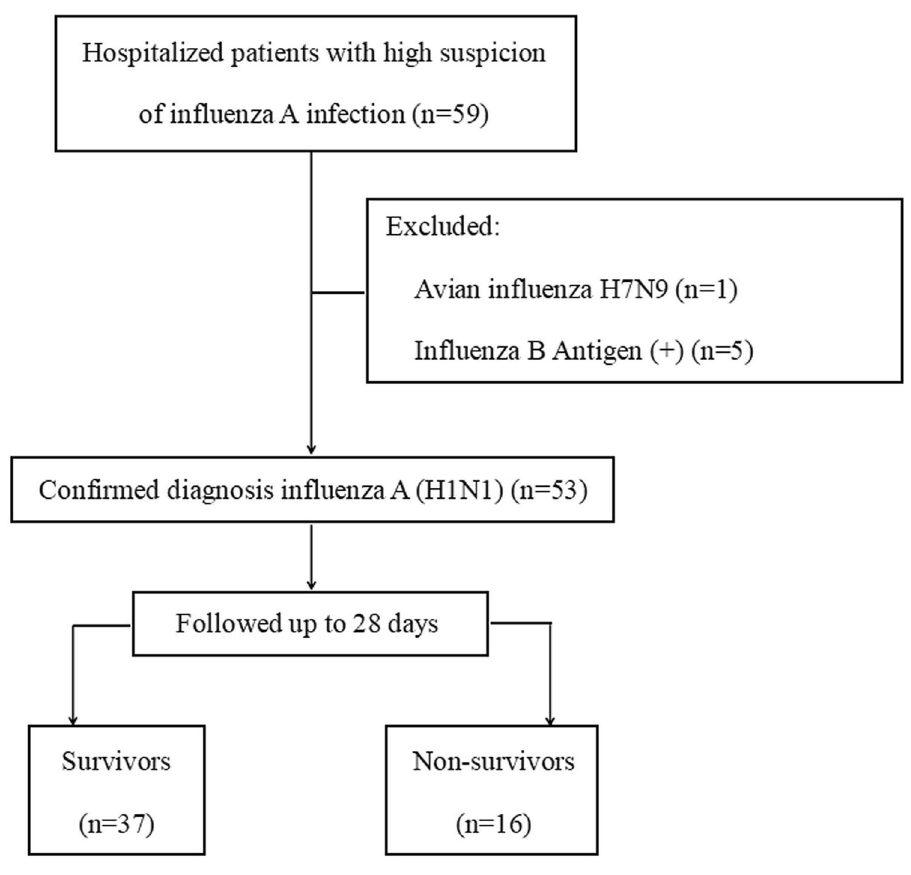
Figure 1. Flowchart of the